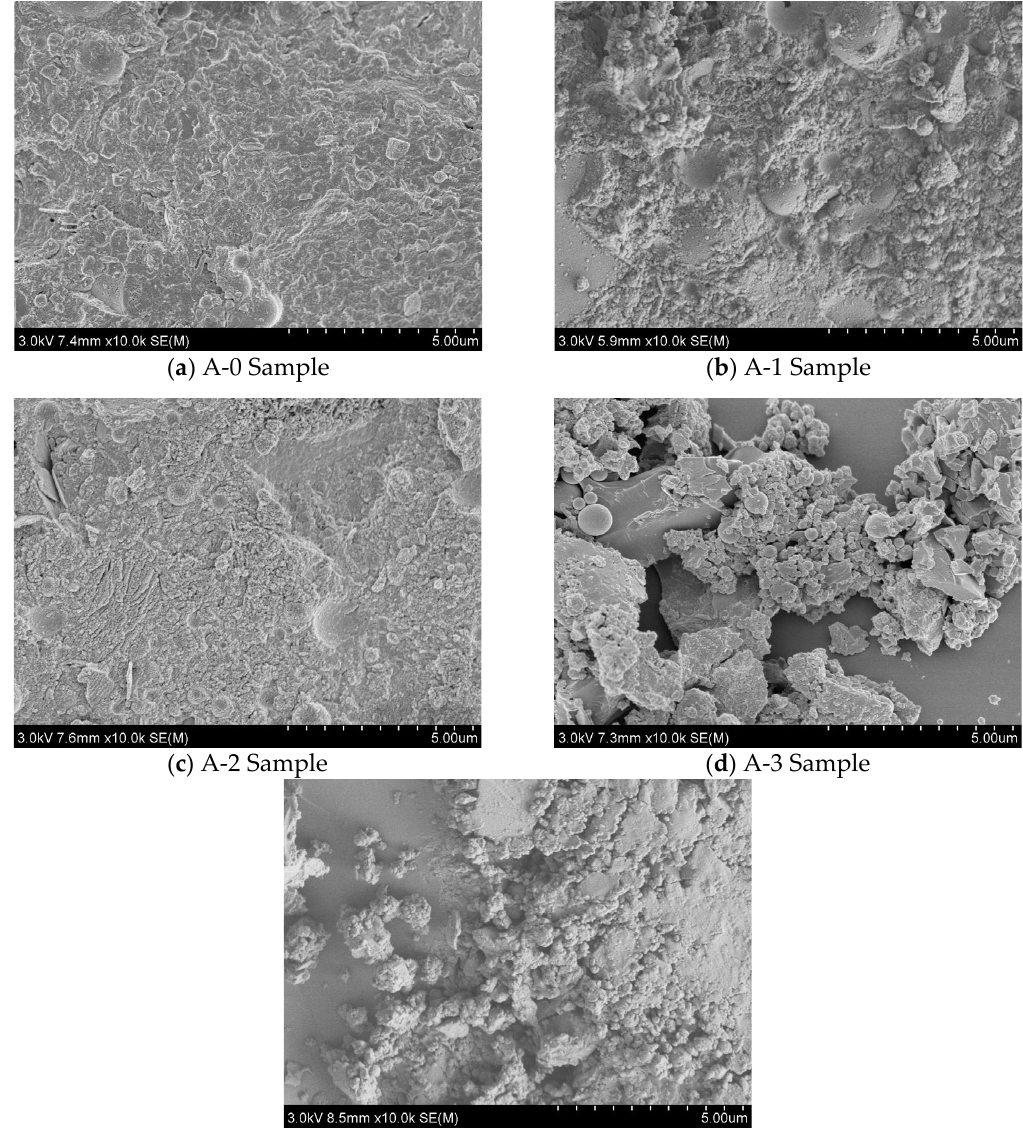
Figure 9. Three-day SEM photo of RPC sample.